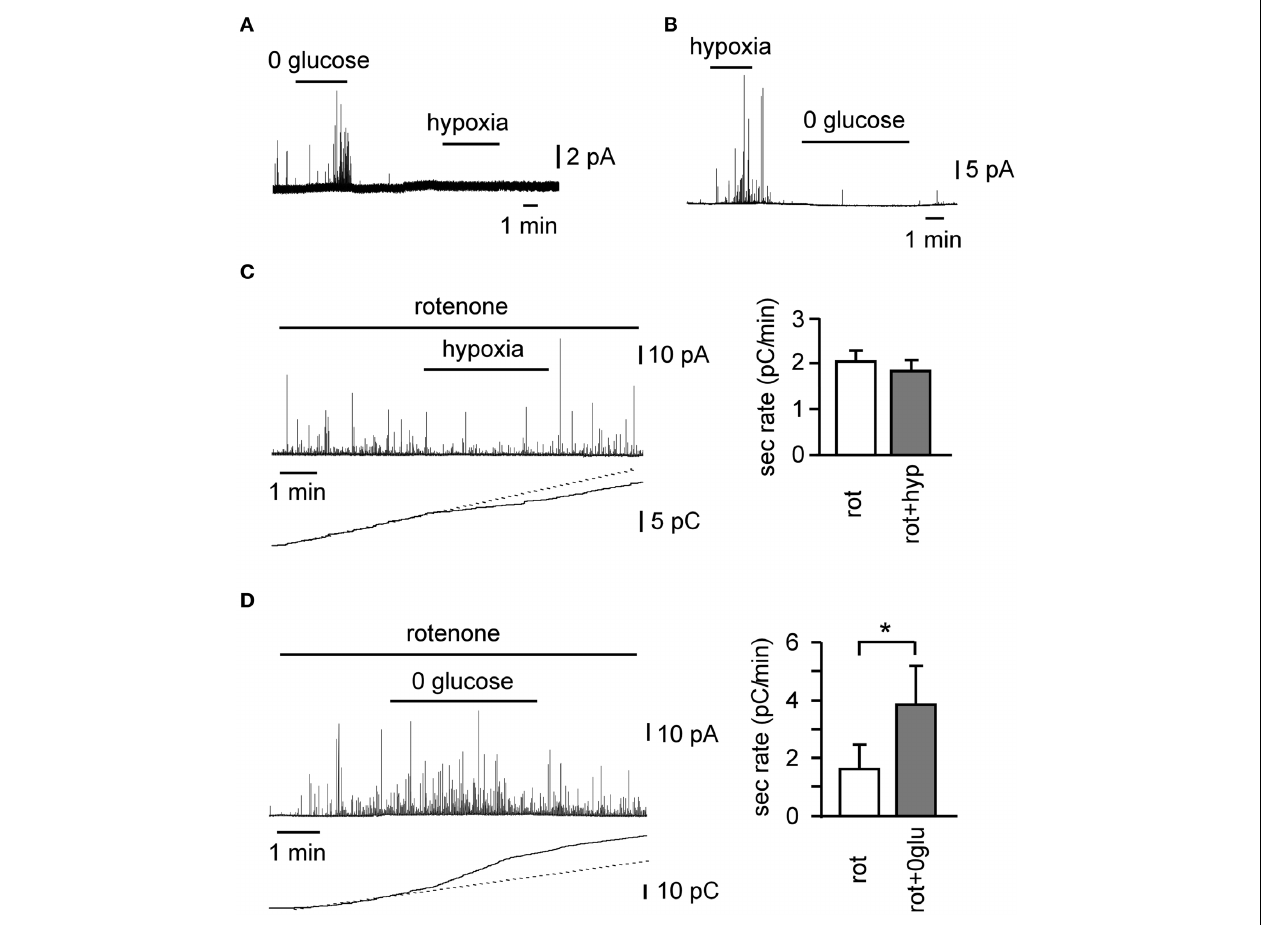
FIGURE 2 | Differential sensitivity of glomus cells to oxygen and low glucose in rat carotid body slices. (A,B) Examples of cells with differential secretory responses to hypoxia and low glucose. Differential effect of 100nM rotenone on the secretory response induced by hypoxia